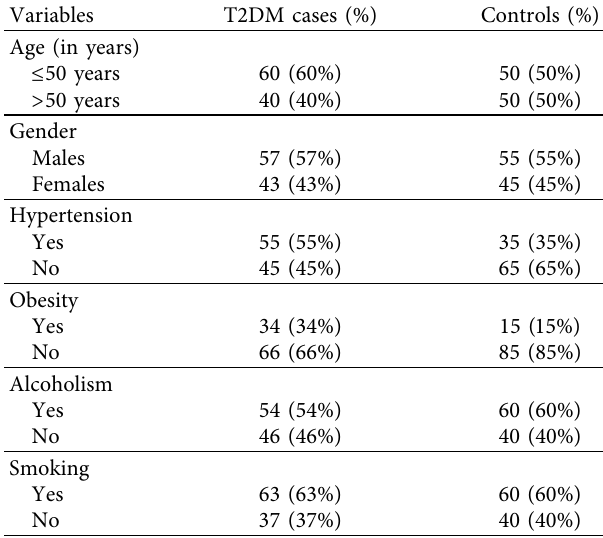
Table 1: Demographic and clinical characteristics of T2DM pa- tients and controls